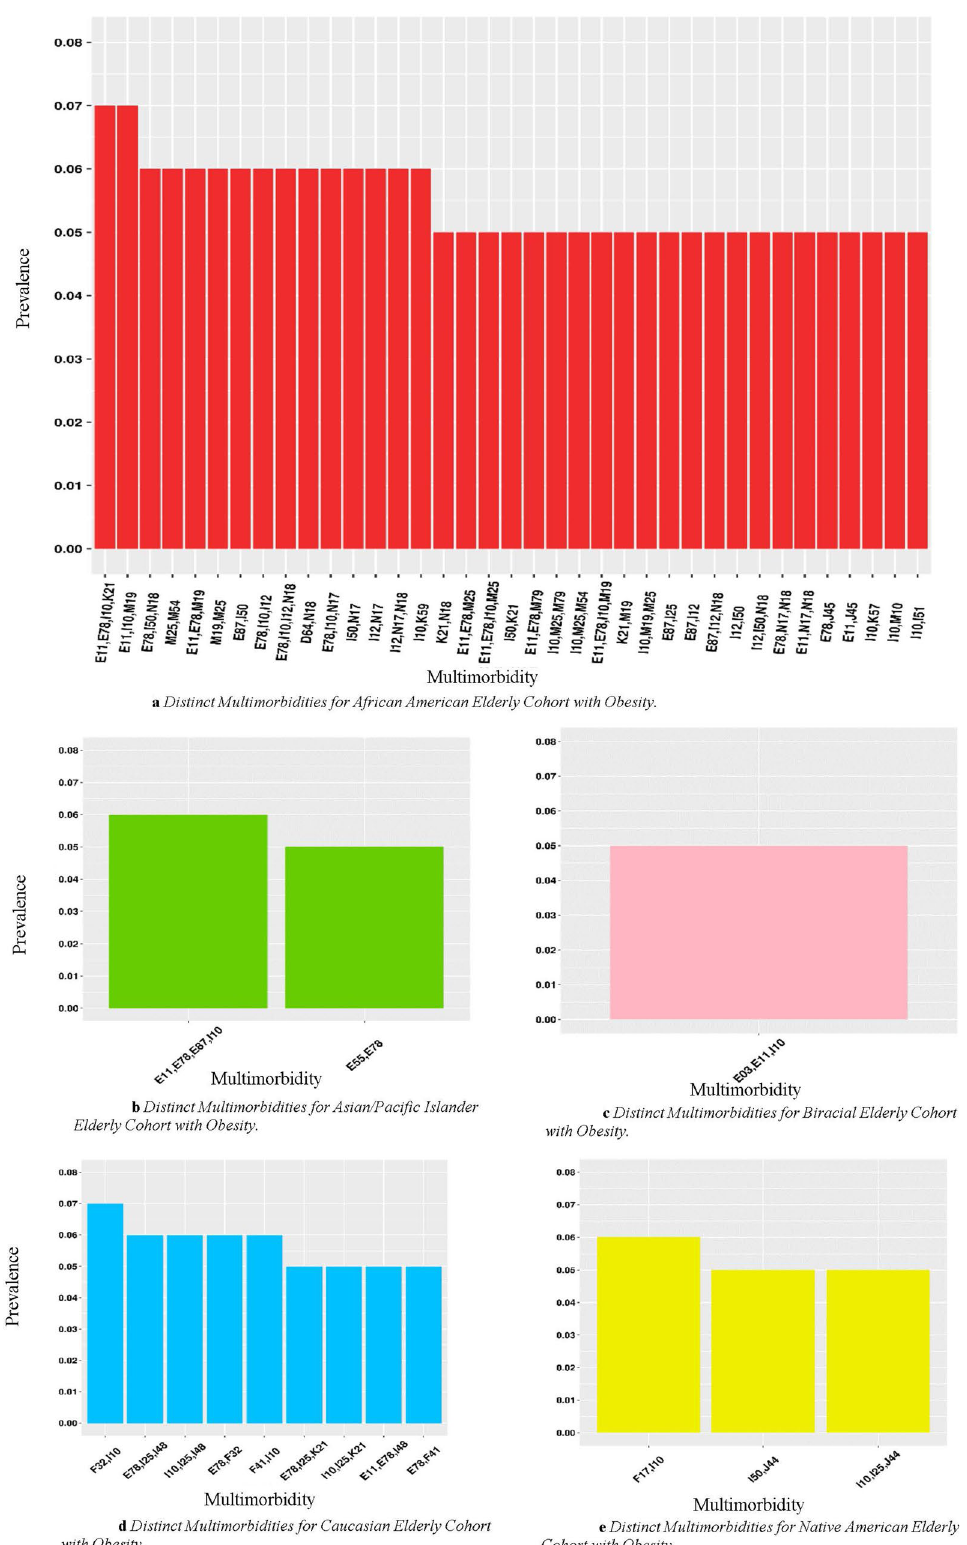
Figure 5. ( a – e ) Demonstrate distinct multimorbidities across races in elderly patients with obesity at 5% prevalence threshold. Disease Clinical Categories; D: Blood and immune mechanism disorders, E: Endocrine, nutritional and metabolic, F: Mental, behavior and neurodevelopmental, G: Nervous System, I: Circulatory system, J: Respiratory system, K: Digestive system, N: Genitourinary system, M: musculoskeletal system and connective tissue. The g-test of independence was calculated resulting in all significant results with p <